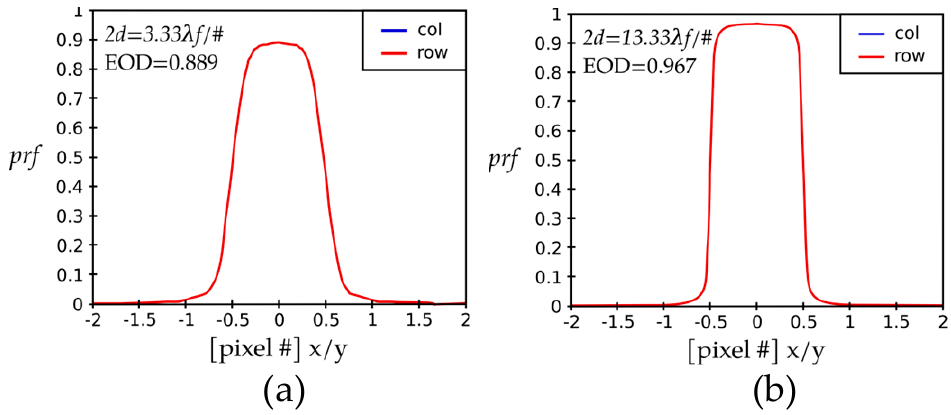
Figure 8. Two prf -s vs. pixel number shown for two orthogonal directions, x and y (in the inset denoted as red, rows, and blue, columns): ( a ) 2d = 3.33 λ F/# and ( b ) 2d = 13.33 λ F/# . Pixel coordinates along both dimensions are, in both cases, normalized to the pixel size. The general features of the curves for the small ( left ) and large ( right ) pixel sizes are quite similar, except that the peak for the smaller pixel ( 3.33 λ F/# ) is decreased by about 4% with respect to the peak of the large pixel. Additionally, the top of the profile for the smaller pixel size ( left ) is more rounded and narrower than that of the large pixel ( right